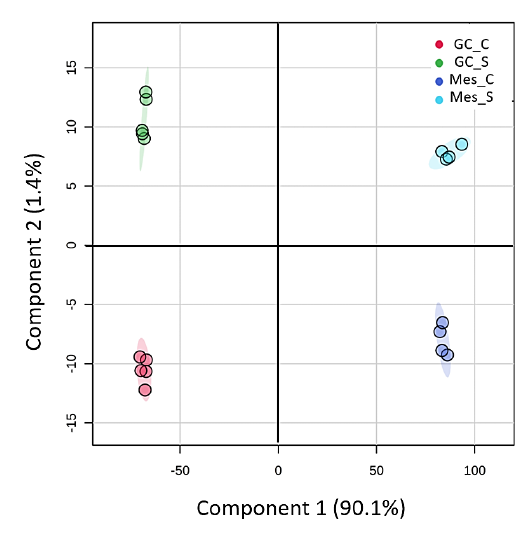
Figure 10. PCA clustering based on mesophyll and guard cell proteome data under control and salt conditions. Proteomics analyses were performed with 4 and 5 biological replicates for mesophyll and guard cells respectively. GC: guard cell; Mes: mesophyll, C: control conditions, S: saline conditions (300 mM NaCl).